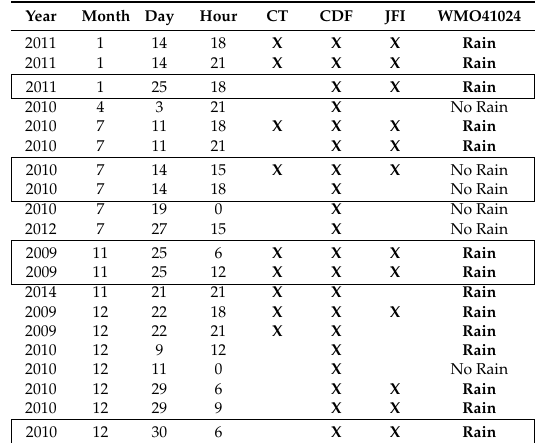
Table 7. Updated flood estimations and rain observations at WMO station